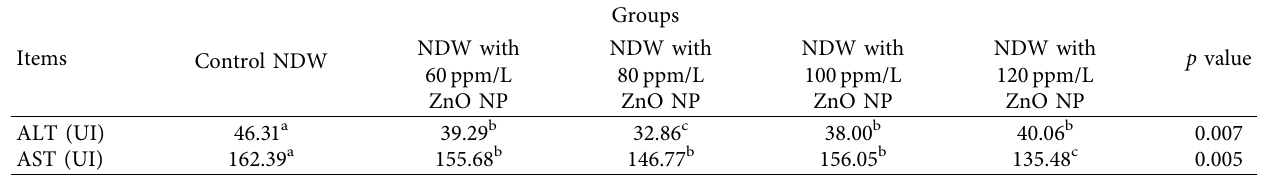
Table 5: Efect of zinc oxide nanoparticles (ZnO NPs) on liver enzyme activity at 35 days of age. Items